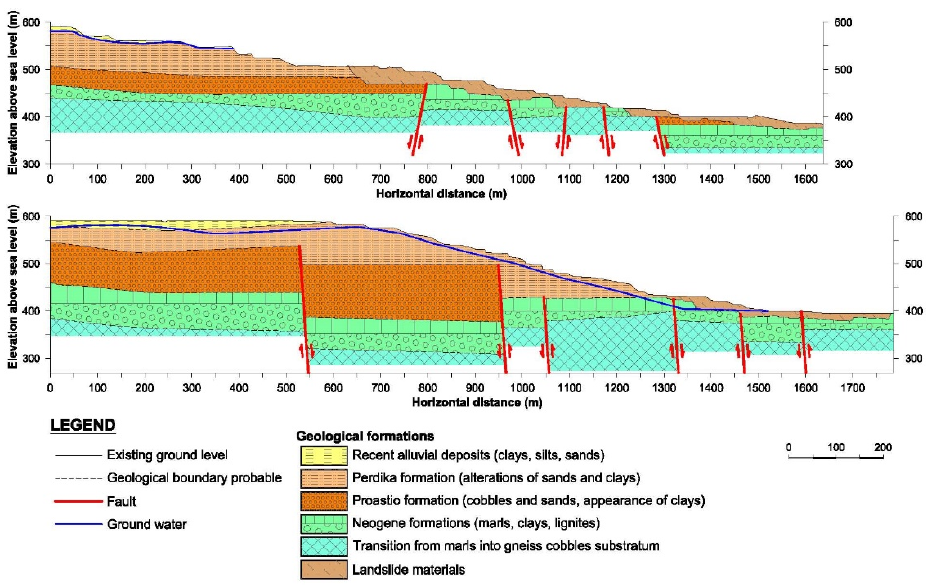
Table 1. Geotechnical parameters used in the stability analyses.